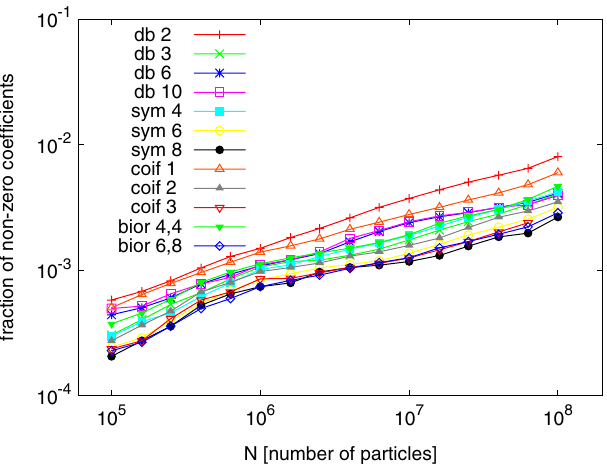
FIG. 5. Sparsity of the wavelet-denoised representation of the flattop distribution used in Sec. IV, quantified by the fraction of nonzero wavelet coefficients after thresholding. Wavelet families used are: Daubechies of order 2, 3, 6, 10; symlets of order 4, 6, 8; coiflets of order 1, 2, 3; and biorthonormal (4,4) and (6,8).